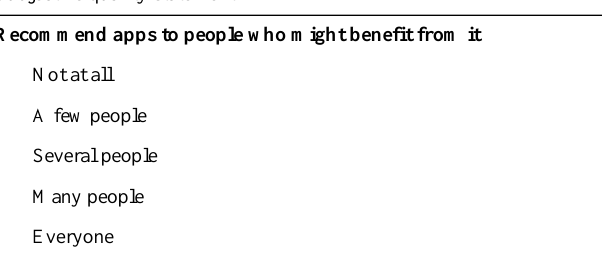
Apps, n (%)Subjective quality statement